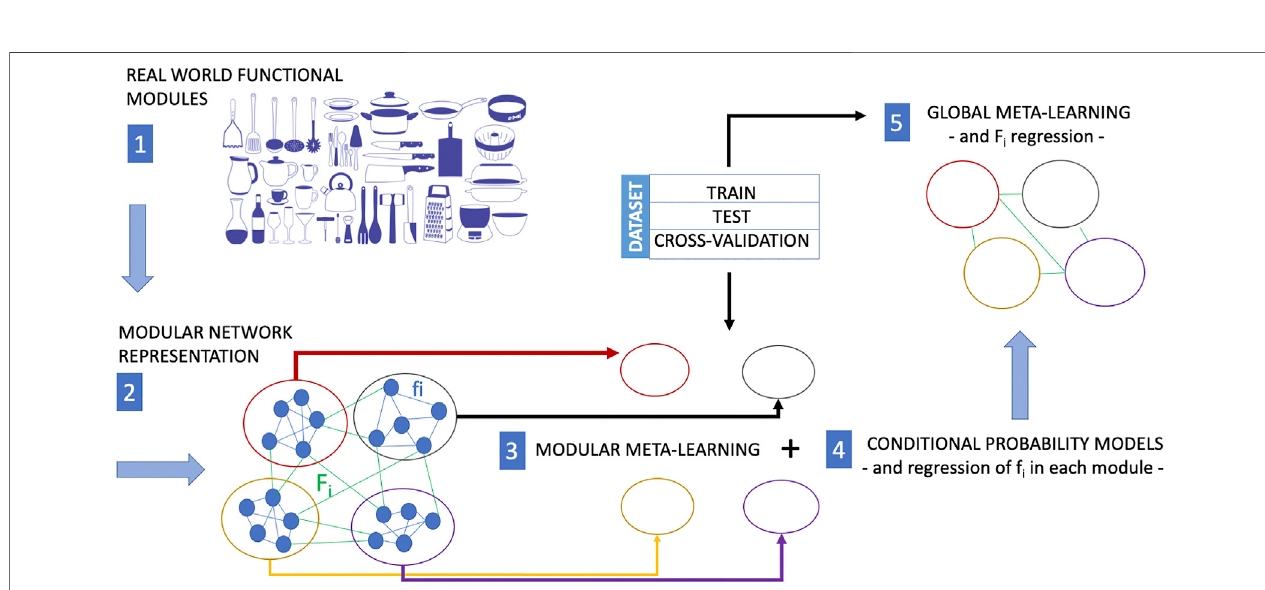
FIGURE 2 | In many situations, training experience is very expensive. While meta-learning is a strategy to reduce the training-data requirements for a new task, modular meta-learning is a strategy to reduce or save computational resources. Modular meta-learning methods learn sets of network modules of a biological network. This learning scheme aims at mimicking the animal brain which is capable to factor out variations of a context or a task, and by virtue of this ability it does not need to implement different algorithms in separate anatomical regions to learn each single variation of a context or task. The functional modularity of a real system (here represented as a collection kitchen utensils with different functions) is fi rst mapped into a modular network (each module of which performs a different function). The causal structure of processes within each module can be learned by modular meta-learning methods, and fi nally the causal structure of the interactions among network clusters is learned by meta-learning approaches including regression of the functions f i internal to each modules (modular meta-learning) and then of the F i representing the cross-talksbetweenclusters(global meta-learning). The image ofthe kitchen utensilsin this fi gure ispart ofthe Pixabay freeonlinepictures (https://pixabay.com/it/).